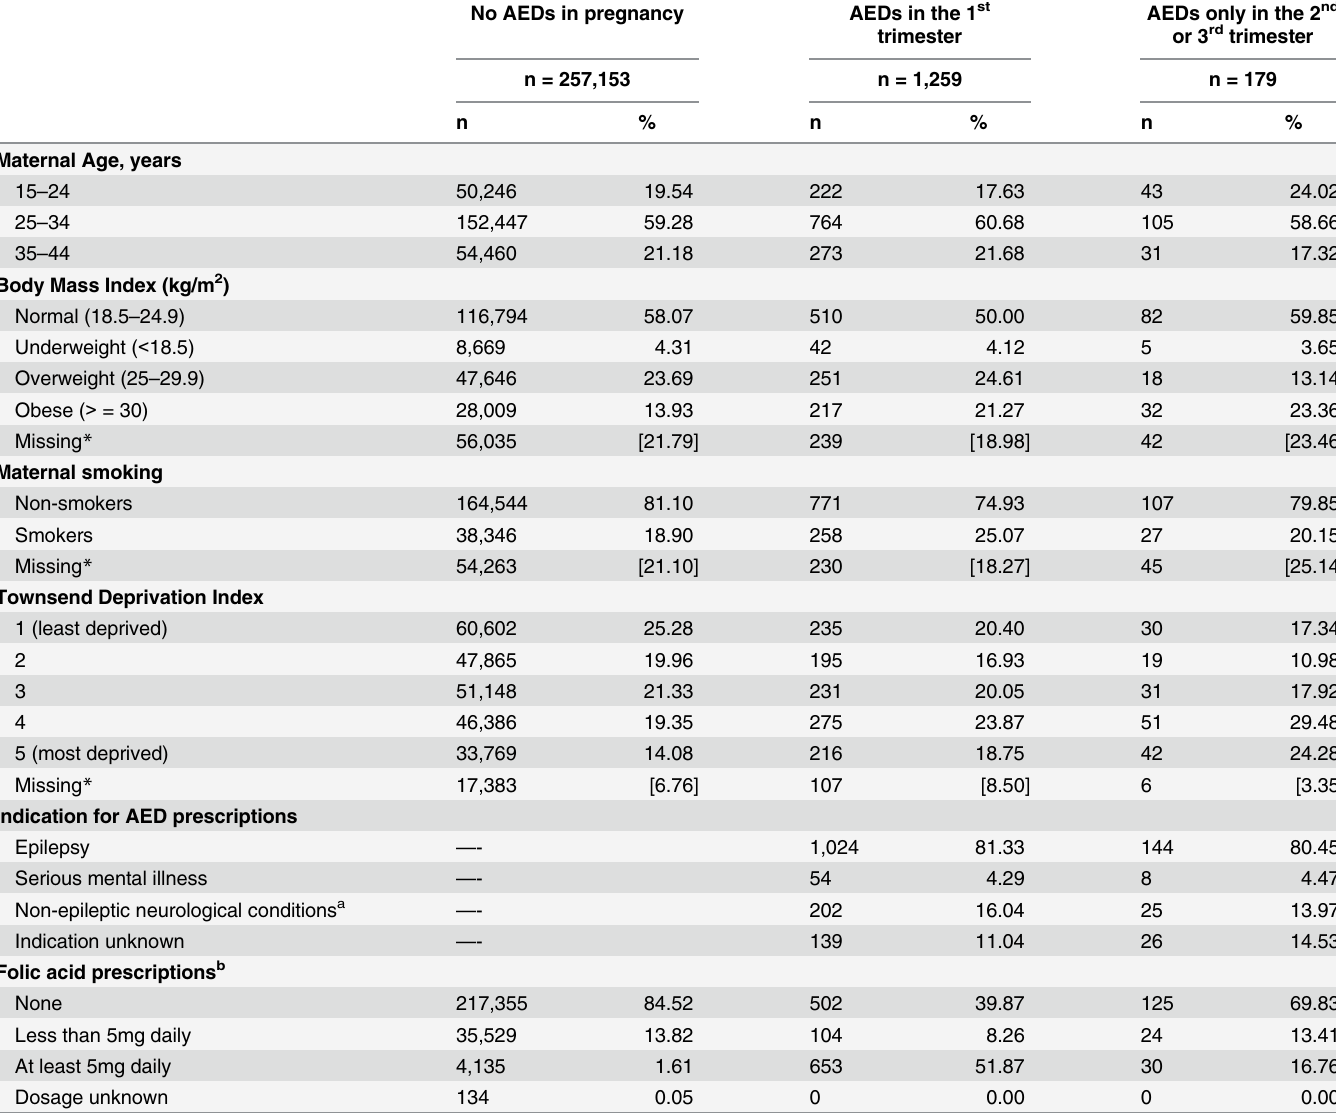
Table 1. Maternal characteristics for children according to their mothers ’ prescriptions of antiepileptic drugs in pregnancy (N =